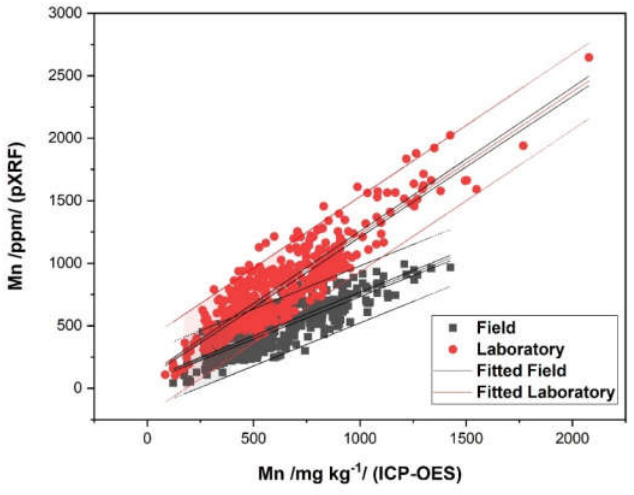
Figure 3. Statistical significance of regression model for Manganese (pXRF) in soil samples from experimental soil sites from Otava and Mže river basins measured in FIELD and LABORATORY.